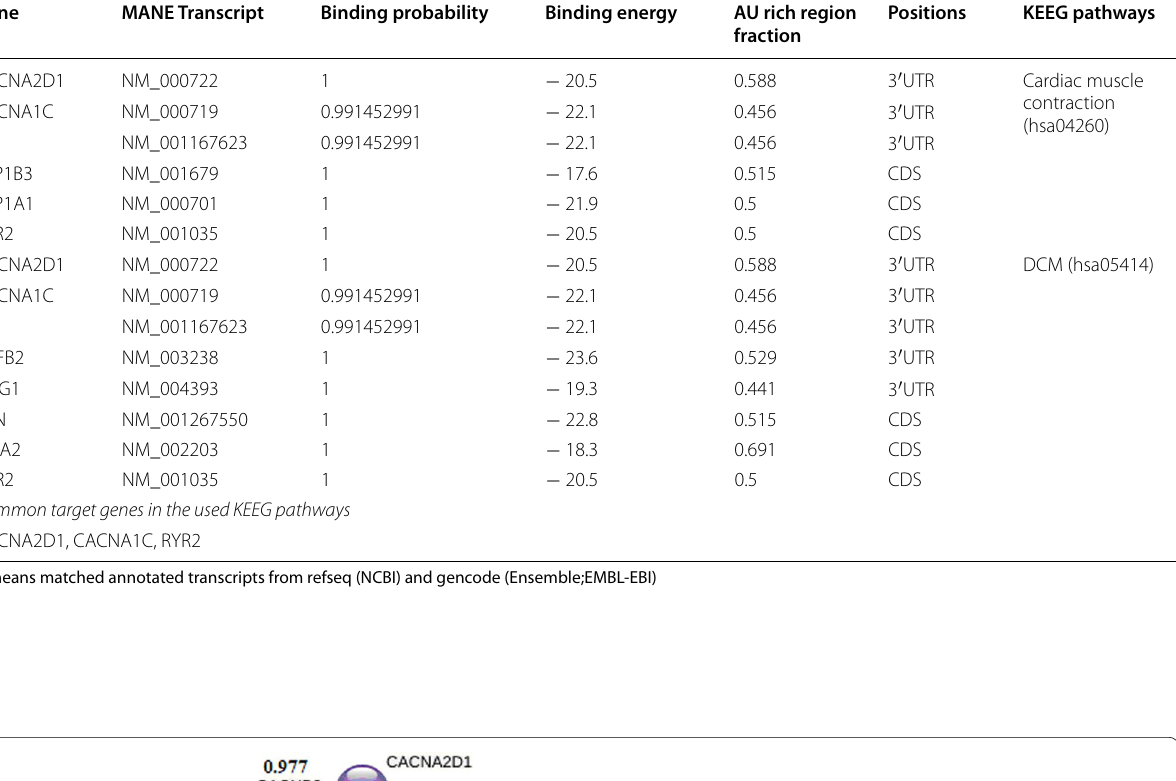
Table 4 Predicted targeted genes for has‑mir‑194‑5p (based on MANE transcript)